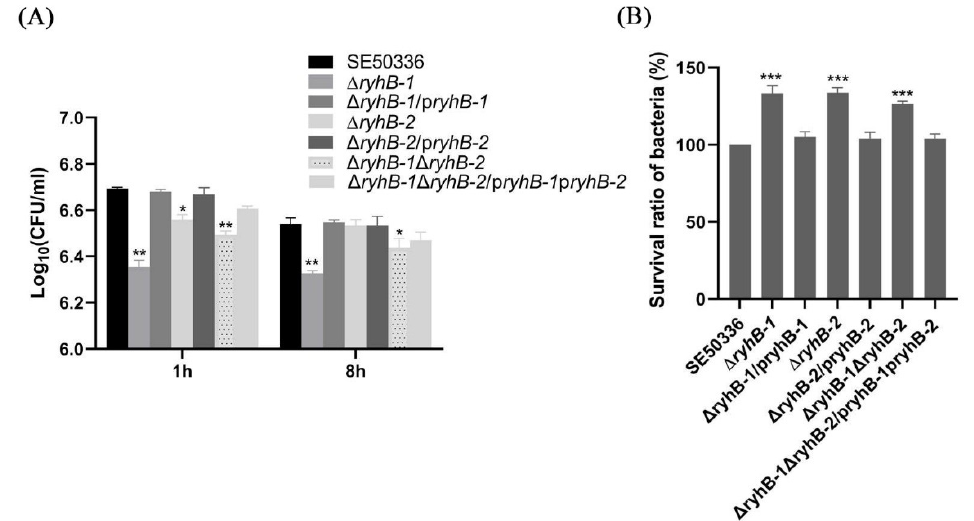
Figure 6. Effects of RyhB paralogs on the survival of S. Enteritidis within HD11 macrophages. ( A ) The number of intracellular bacteria was determined at 1 hpi and 8 hpi by plating serial dilutions of HD11 lysates on LB plates for counting CFU. The comparison of intracellular bacteria numbers between the mutants and the WT strain was analyzed statistically using one-way ANOVA. * p < 0.05, ** p < 0.01. ( B ). Survival ratios of the WT strain and RyhB mutants within HD11 macrophages. The survival ratios of bacteria were calculated in terms of the percentage of bacteria number at 8 hpi to the number at 1 hpi for each strain. To compare with the mutants, the survival ratio of the WT strain was set at 100%. The comparison of survival ratios between the mutants and the WT strain was analyzed statistically using one-way ANOVA. *** p < 0.001. All the above assays were performed in triplicate.